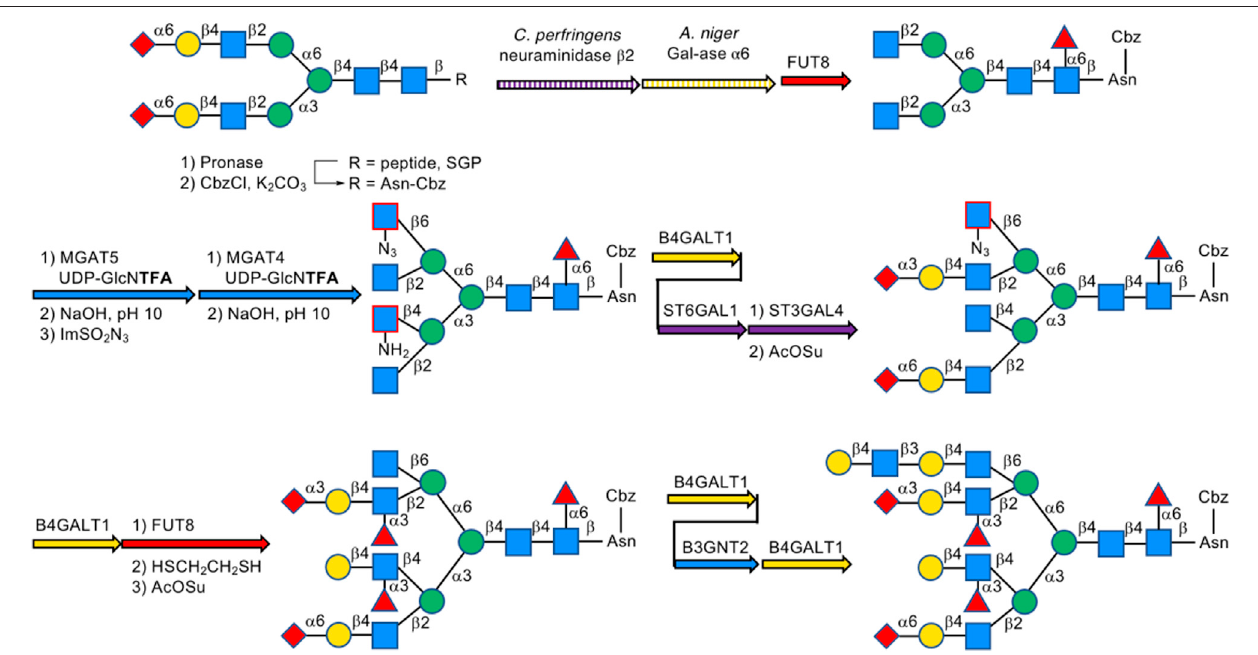
FIGURE 17 | Stop and Go strategy for multi-antennary N -glycans; For MGAT4/5&B3GNT2, B4GALT1, FUT8, and ST3/6GAL1/4, UDP-GlcNAc, UDP-Gal, GDP- Fuc, and CMP-Neu5Ac were used as the donor, respectively, unless otherwise